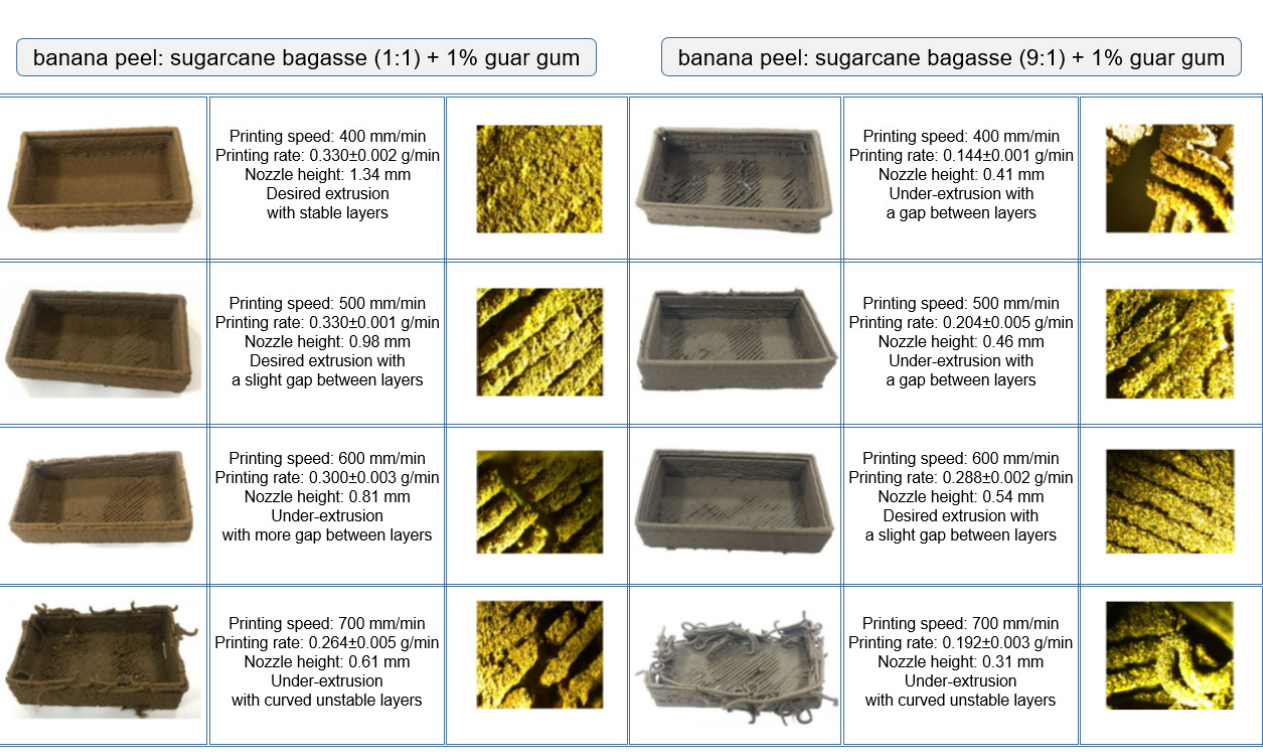
Figure 9. Optimization of material for 3D-printed food packaging from banana peel and sugarcane bagasse with 1% guar gum, using a nozzle diameter of 1.2 mm at 300 rpm motor speed and 3.2 bar pressure “Reprinted/adapted with permission from Ref. [66]. Copyright © 2022, exclusive license to Society for Sugar Research & Promotion, Springer Nature”